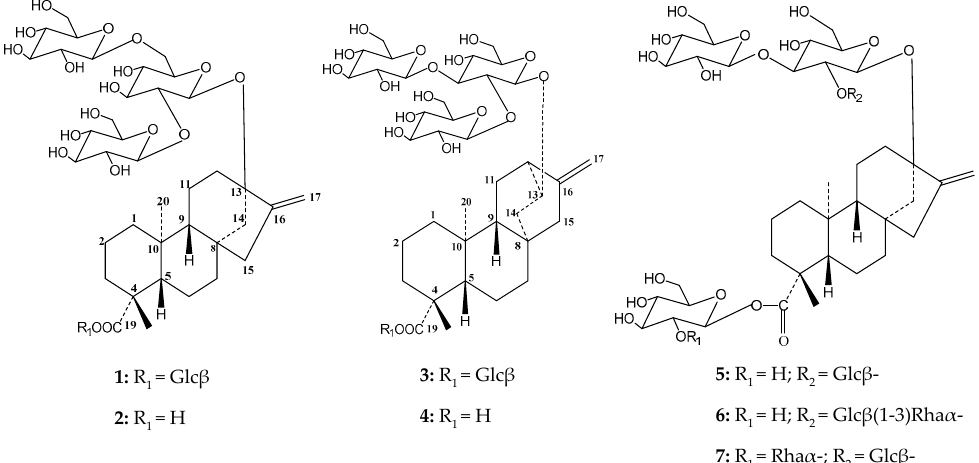
Figure 1. Chemical structures of purified compounds rebaudioside Z (1) and 13-[(2- O - β - D - glucopyranosyl - 3- O - β - D -glucopyranosyl- β - D -glucopyranosyl)oxy] ent -hydroxyatis-16-en-19-oic acid- β - D -glucopyranosy ester ( 3 ) and chemically modified rebaudioside Z 1 ( 2 ) and 13-[(2- O - β - D - glucopyranosyl - 3- O - β - D -glucopyranosyl- β - D -glucopyranosyl) oxy] ent -hydroxyatis-16-en-19-oic acid ( 4 ), rebaudioside A ( 5 ), rebaudioside H ( 6 ) and rebaudioside J ( 7